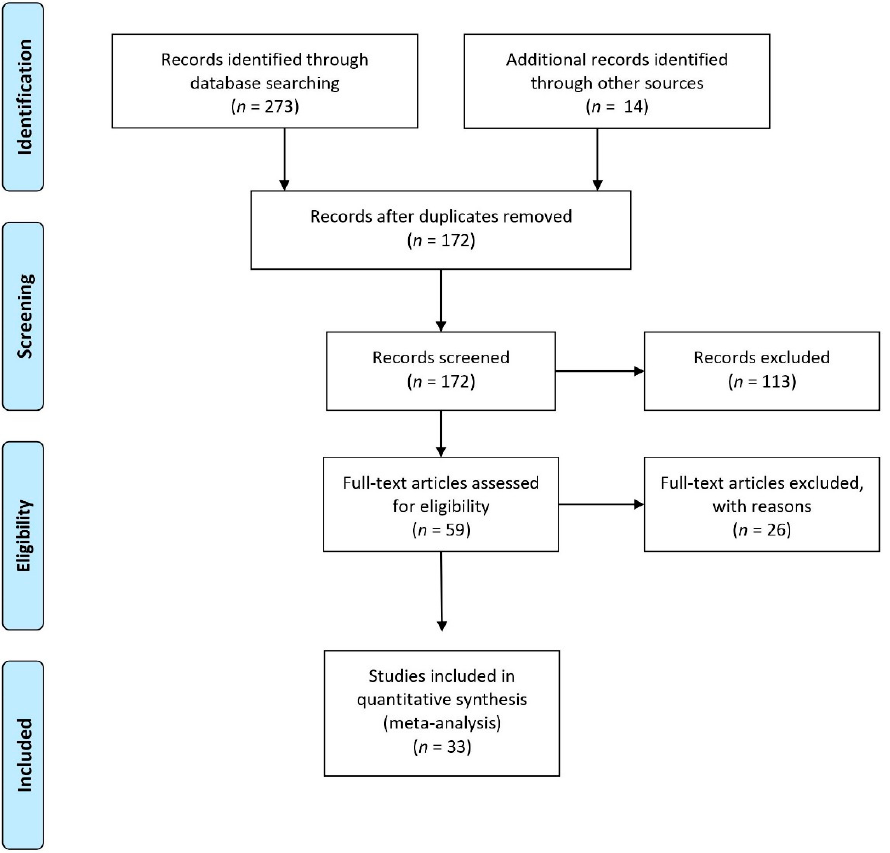
Figure 1. Preferred Reporting Items for Systematic Reviews and Meta-Analyses (PRISMA) flow diagram of the literature search (http://www.prismastatement.org/, accessed on 25 April